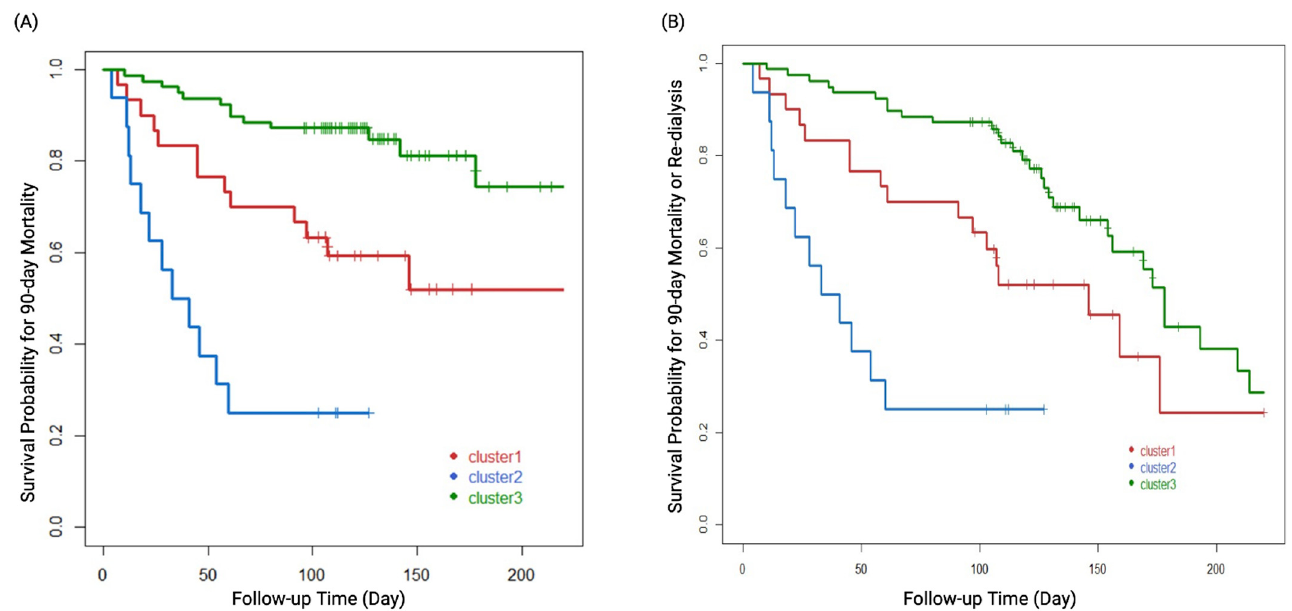
Figure 4. Kaplan–Meier survival plots of the three cluster groups defined by all predictors and ( A ) 90-day mortality. ( B ) Composite outcome of 90-day mortality or re-dialysis. The log rank p values for all comparisons were <0.001.